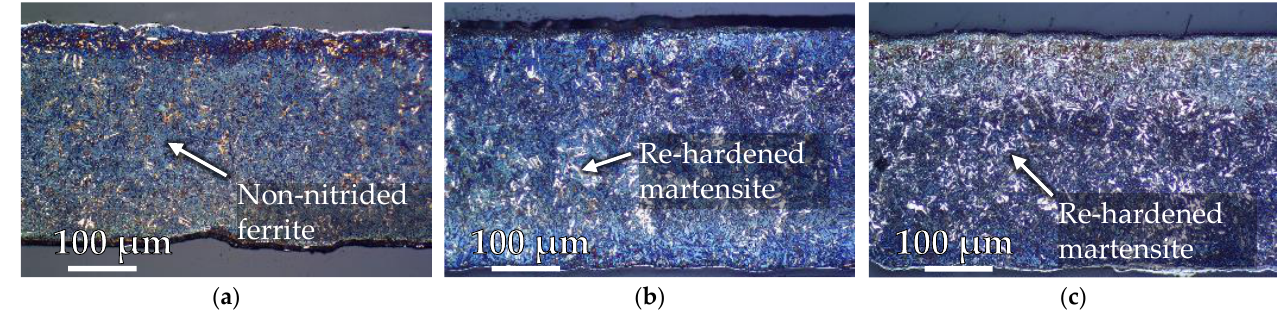
Figure 22. Metallographic sample cross-section ( a ): 32 h PN—reference after nitriding ( b ): 32 h PN, 2000 cycles, 750 °C without stress superposition ( c ): 32 h PN, 2000 cycles, 750 °C with 125 MPa stress superposition.